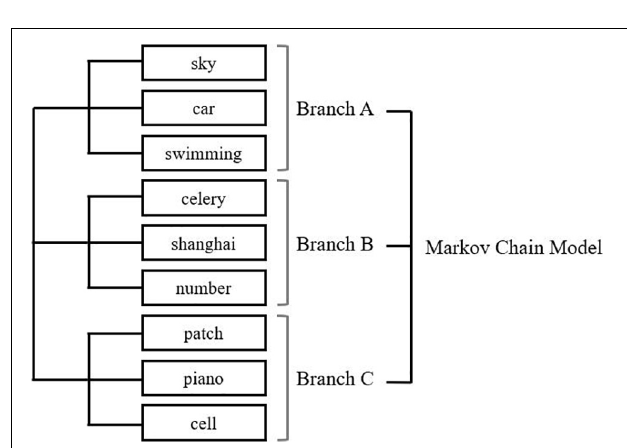
FIGURE 9 | Cluster analysis